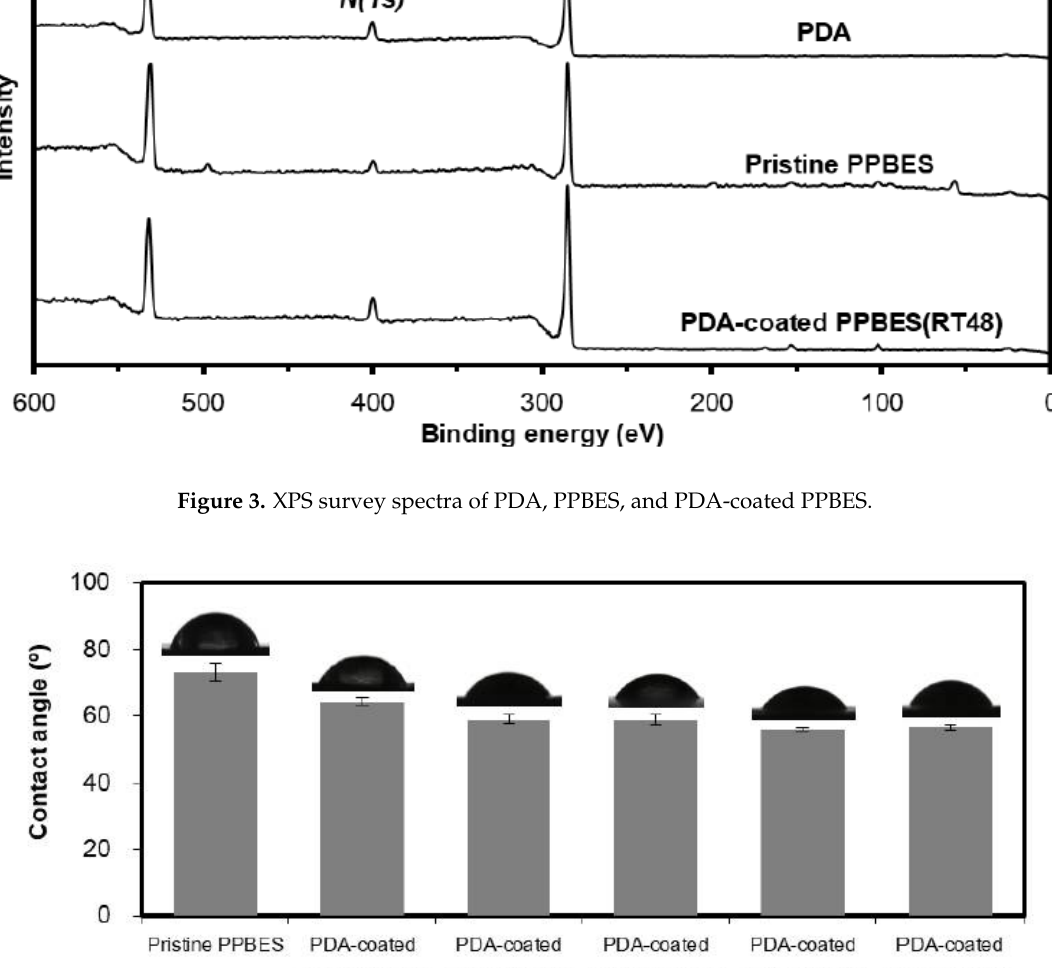
Figure 4. Water contact angles of pristine and PDA-coated PPBES prepared under different reaction